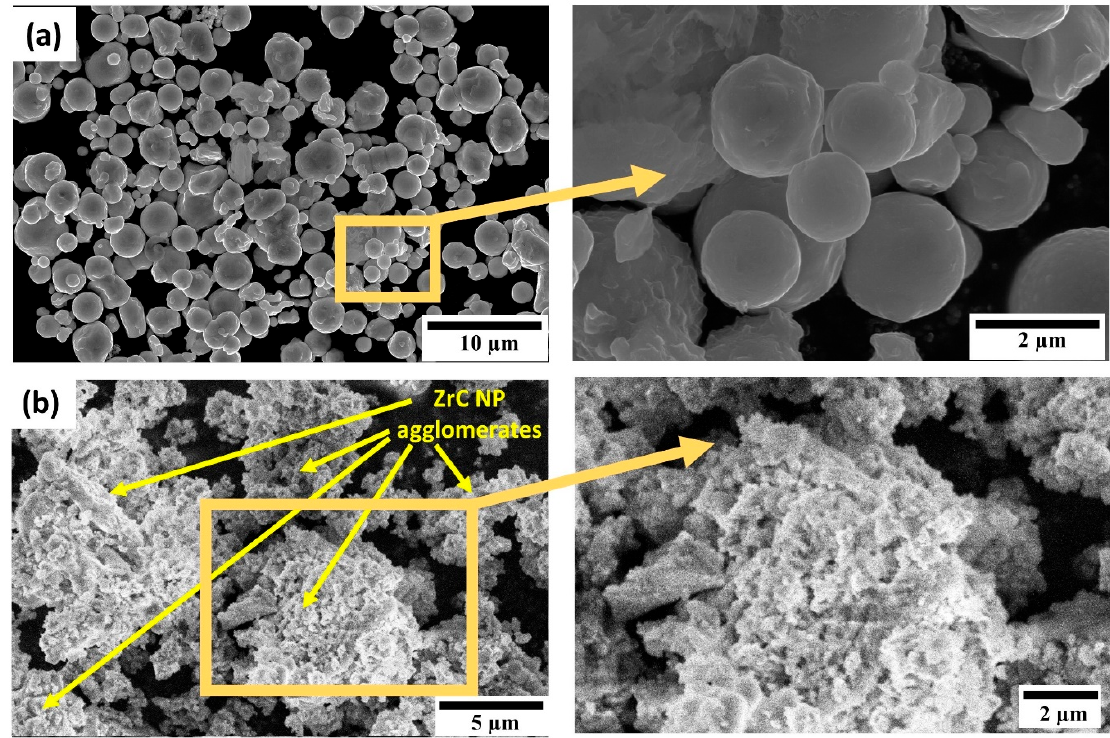
Figure 2. SEM (scanning electron microscopy) micrographs of ( a ) 6–10 μ m Fe and ( b ) 60 nm ZrC nanoparticles.